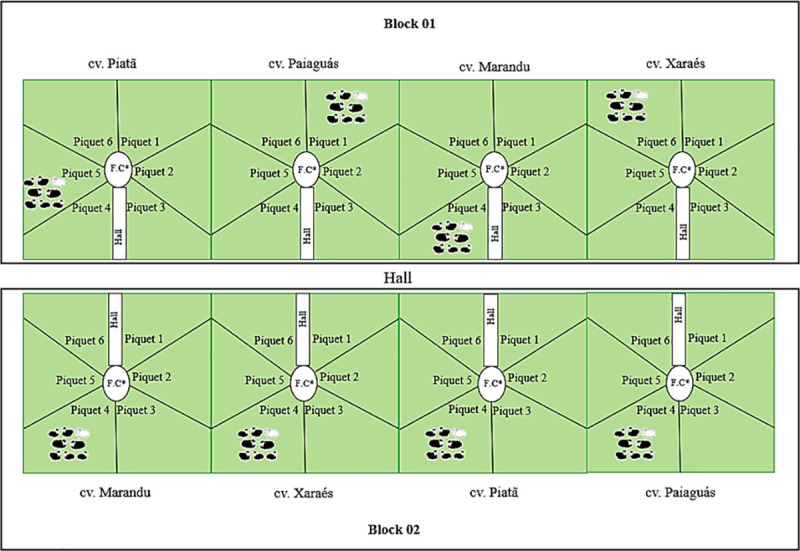
Sketch of the distribution of experimental blocks, modules and paddocks, according to the cultivars Marandu, Xaraés Piatã and Paiaguás.* Food court.